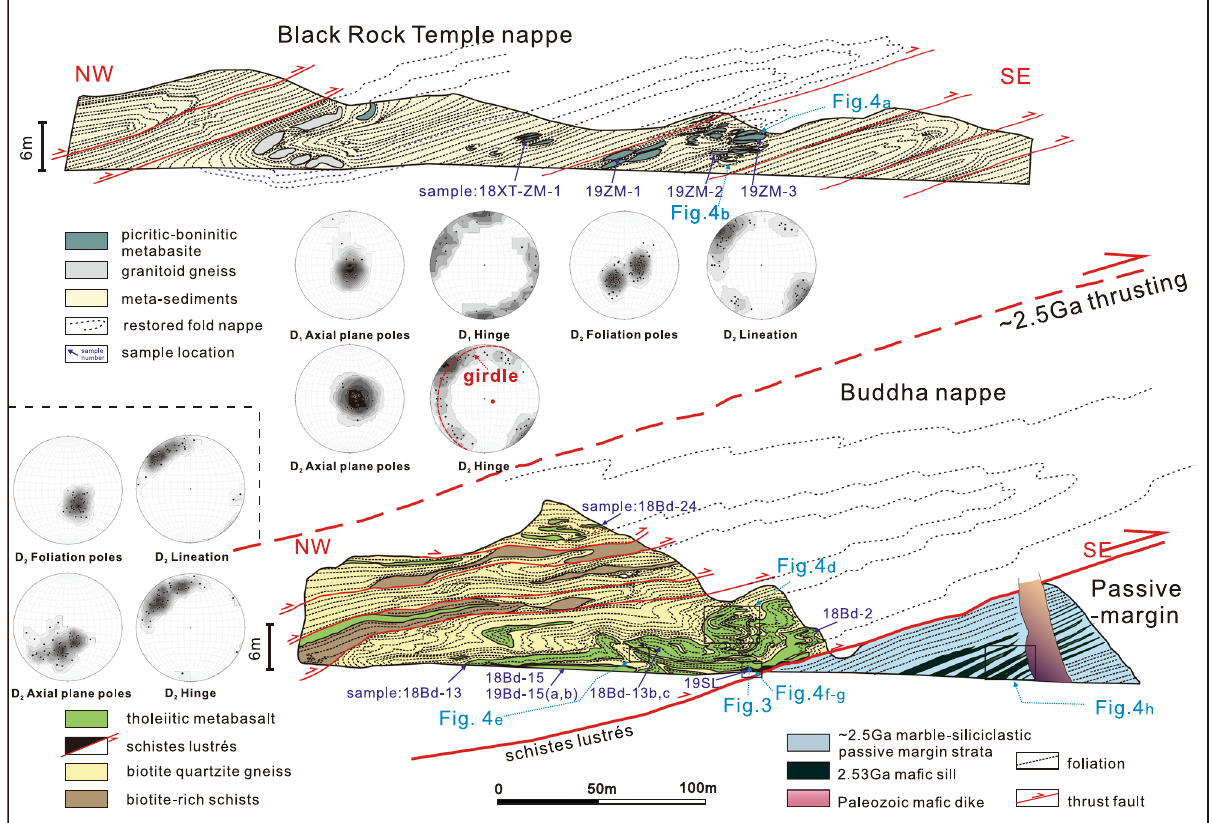
Fig. 2 Pro fi le of Black Rock Temple and Buddha nappes (both named after local names); lower-hemisphere equal area stereographic projections of D 1 and D 2 axial surfaces, fold hinge lines, and lineations. Structural data for Black Rock Temple nappe is above dashed line, for the Buddha nappe, below line. Mapping was performed at a scale of